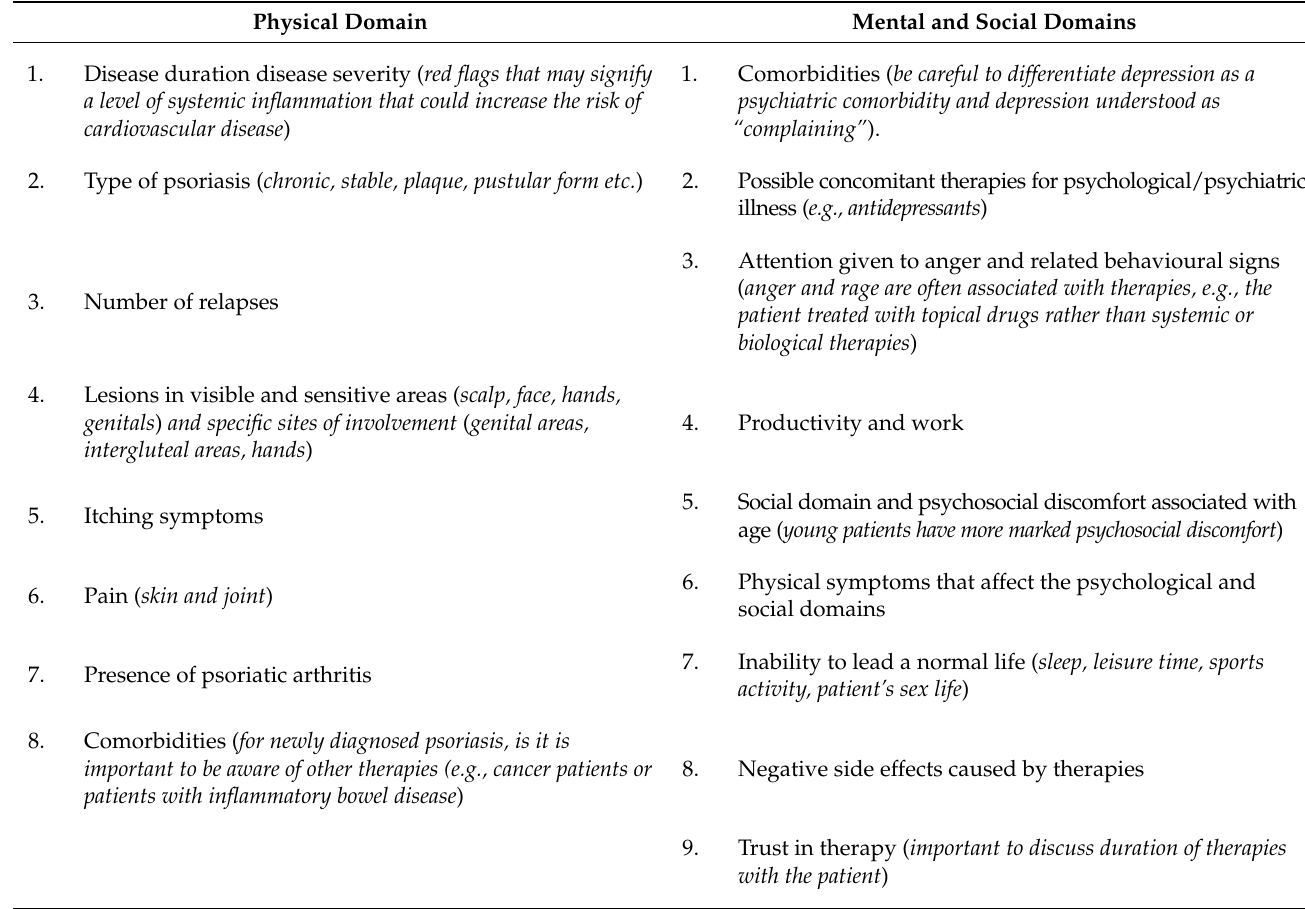
Table 4. The most important domains (physical, social and psychological) to consider—output from interactive workshop